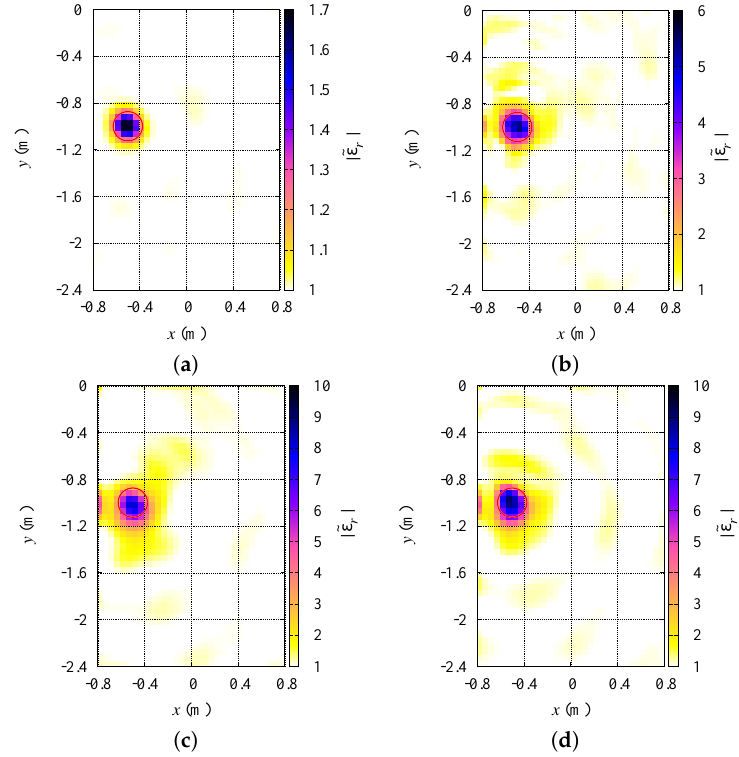
Figure 9. Variation of the dielectric properties. Reconstructed distributions of the magnitude of the complex dielectric permittivity inside the investigation region: ( a ) (cid:101) r = 1.5; ( b ) (cid:101) r = 6; ( c ) (cid:101) r = 10; ( d ) (cid:101) r =